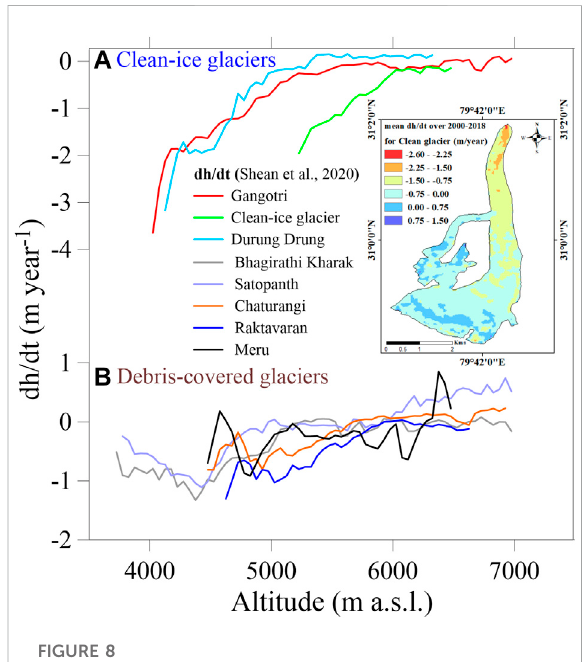
FIGURE 8 (A) Shows the patterns of thinning rate (dh/dt) for clean ice glaciers and (B) shows the patterns of thinning rate for debris- covered glaciers. Inset of panel A is the randomly selected clean